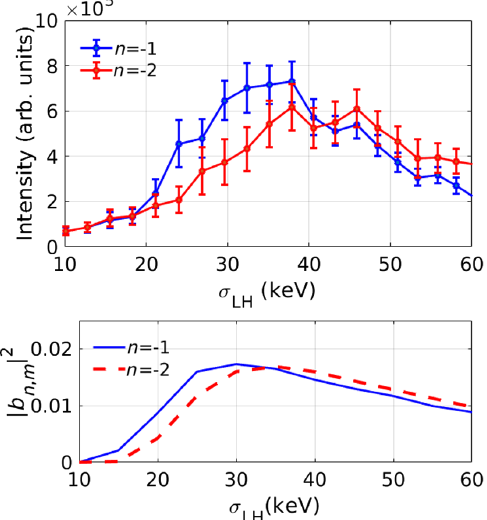
¼ FEL FIG. 4. Top: FEL intensity vs LH-induced energy spread. The FEL parameters are same as in Fig. 2. Bottom: square bunching factor. The calculated value of p 1 ð λ μ Þ and p 2 ð λ μ Þ in Fig. 2 are used to evaluate bunching